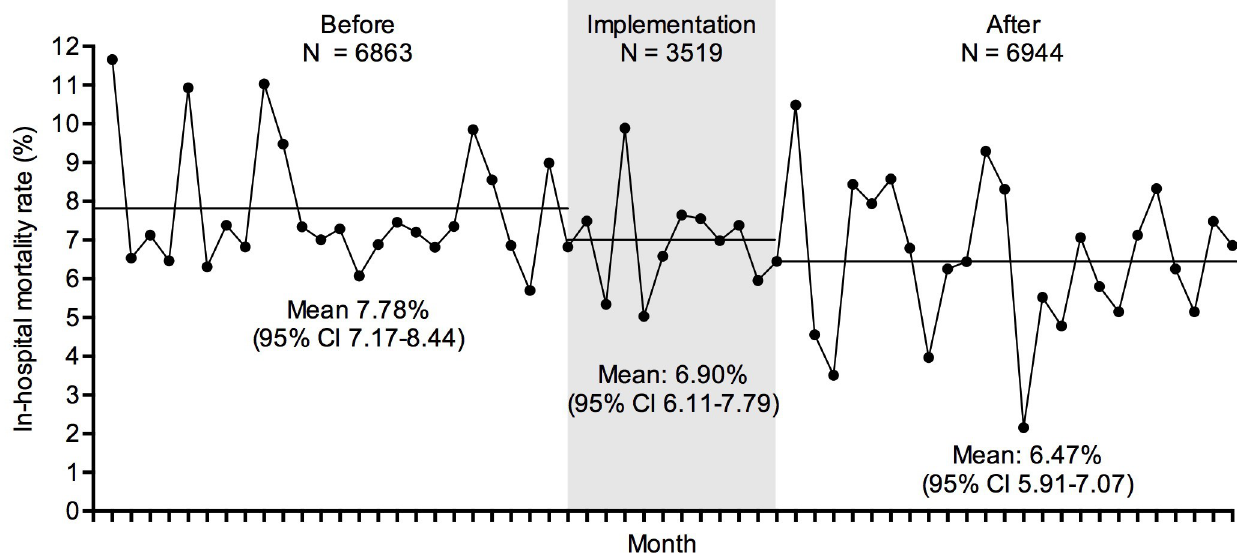
Fig 3. Panel data line graph illustrating the monthly in-hospital mortality rate in each study period according to the rapid-response team (RRT) trigged by the Modified Early Warning Score (MEWS) � 4 implementation (before, during, and after). The horizontal line illustrated the mean of the in-hospital mortality in each period and these means and their respective 95% confidence interval (CI) were shown on the bottom of the panel.